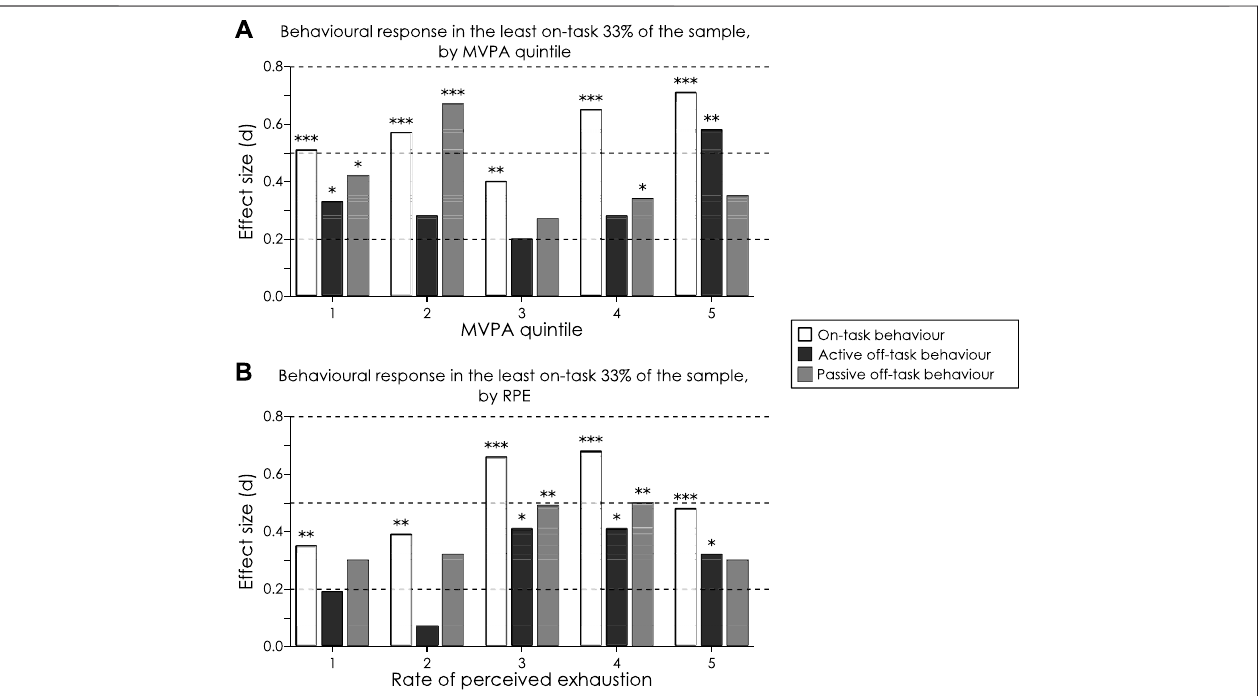
FIGURE 4 | Change in behaviour in response to objective and subjective measures of physical activity intensity in the least on-task participants. (A) Behavioural response in the least on-task 33% of the sample, MVPA quintile (B) Behavioural response in the least on-task 33% of the sample, by RPE. Note. MVPA (cid:1)